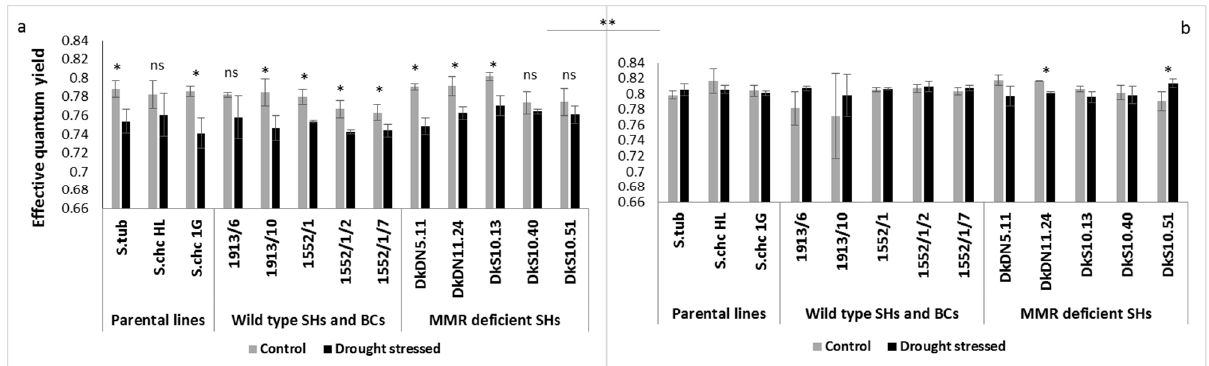
Figure 12. Effective quantum yield (mean ± SE, n = 3) of SHs, BC1 clones, and parental lines in control and drought conditions: ( a ) first fluorescence measurements, ( b ) second measurements. ** indicates significant differences ( p < 0.001) in the total PI indexes of the first measurements compared to second measurements; * denotes significant differences ( p < 0.05) between control and drought stressed plants; ns means no significant differences ( p > 0.05) between control and stressed plants.